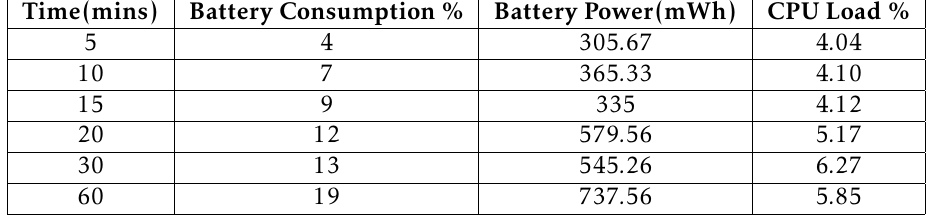
Table 3. AndroCon testing Results